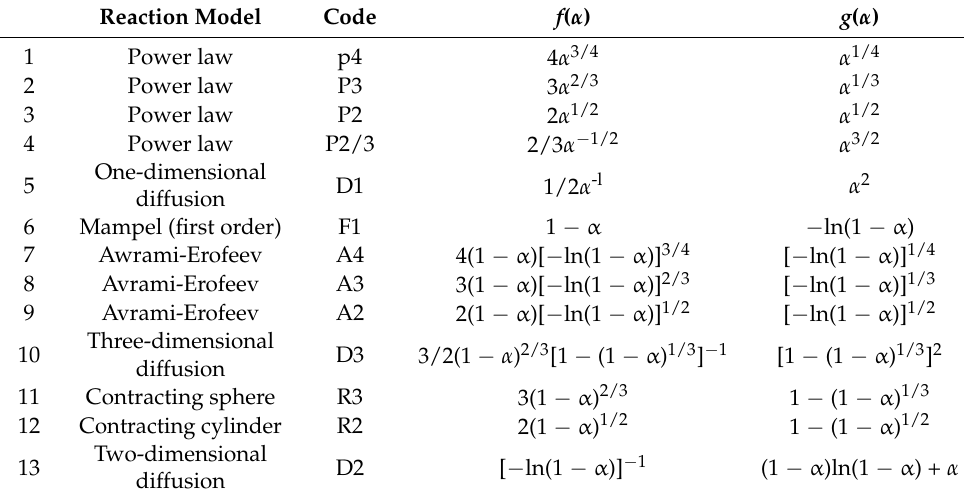
Table 1. Reaction models of solid-state